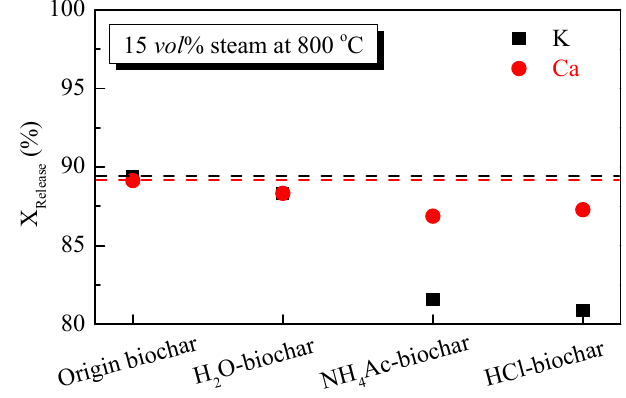
Figure 6. Release of K and Ca species during the steam gasification of biochar.